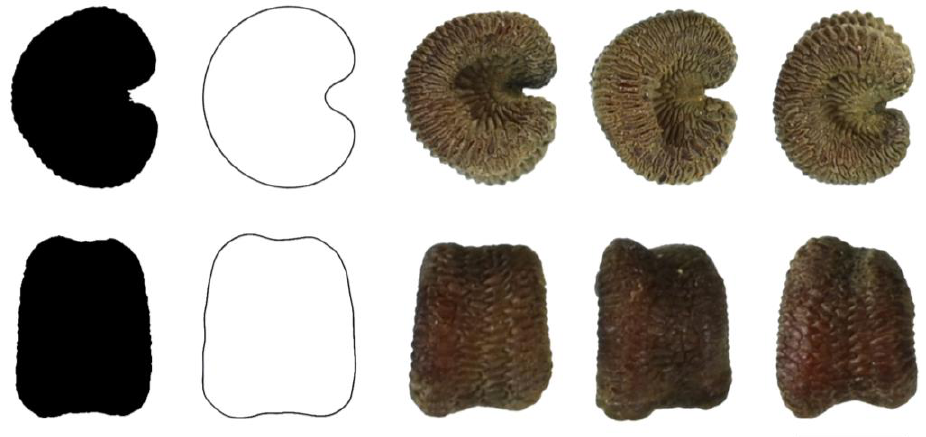
Figure 16. Silene linicola : average silhouettes (left), the models giving best scores with 20 seeds (LM5 and DM12), and three representative images for the lateral (above) and dorsal (below) seed views. Bar represents 1 mm.